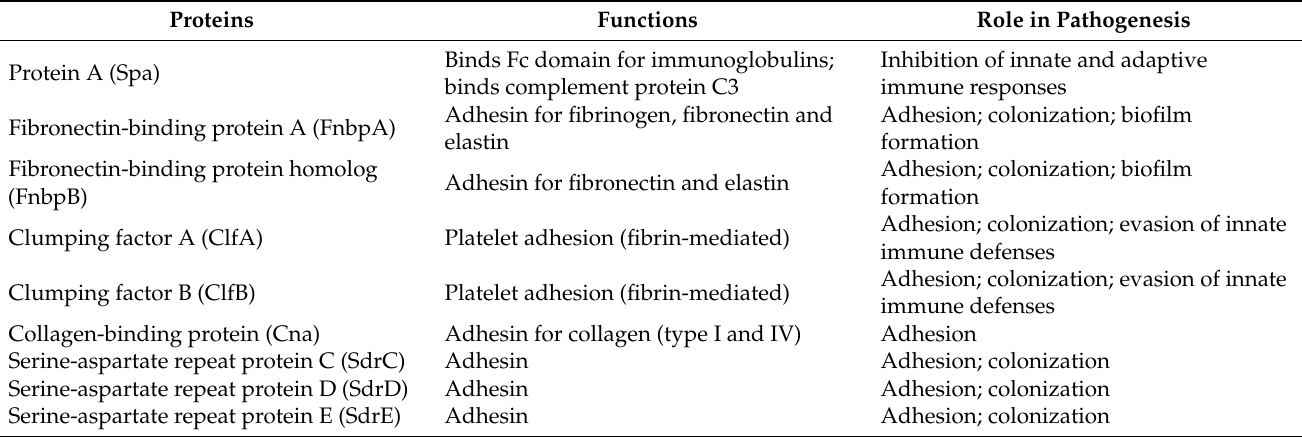
Table 1. Examples of the main MSCRAMMs with adhesive